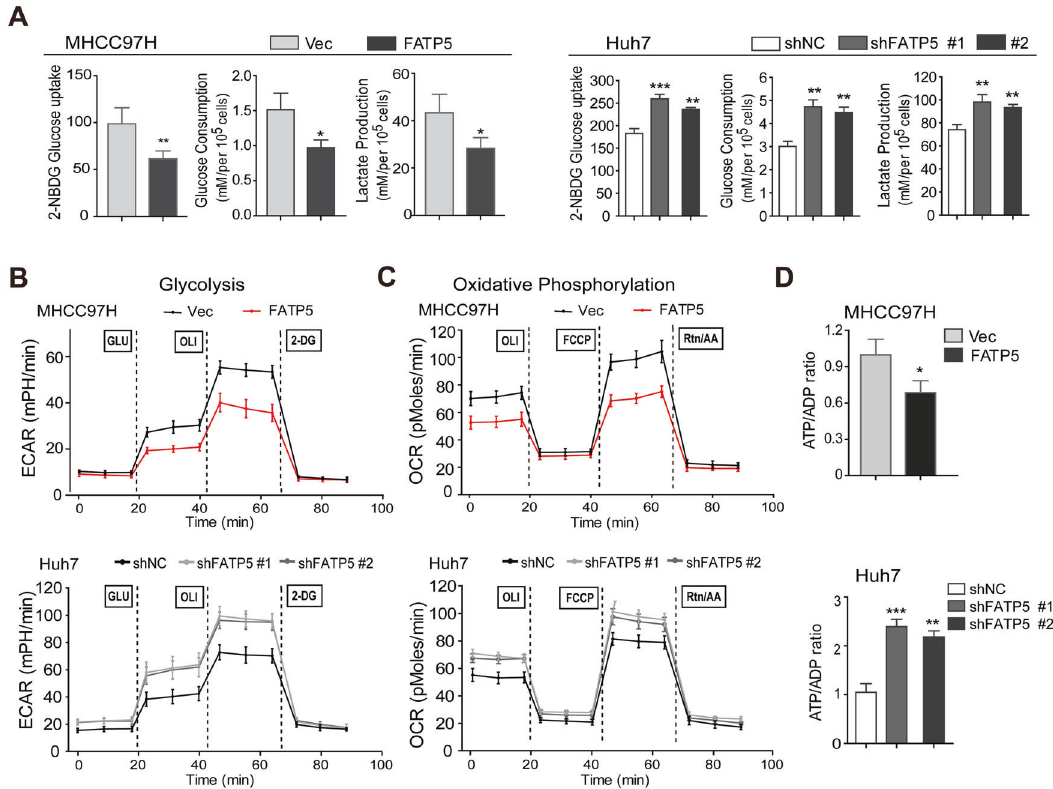
Fig. 4 FATP5 induces the activation of AMPK by reprogramming glycolysis and energy metabolism of HCC cells. A HCC cells were incubated with 2-NBDG for 30 min and then washed and re-suspended with DMEM medium. The cellular fl uorescence intensities were measured by fl ow cytometry. Glucose and lactate concentrations in normal culture medium and supernatants after cell incubation for 48 h were detected to calculate the glucose consumption and lactate production. B , C Both extracellular acidi fi cation rates (ECAR) and oxygen consumption rates (OCR) in different time points were measured using a Seahorse XF96 Extracellular Flux Analyzer either under basal conditions or after treatment with according inhibitors. Representative curves were shown and each data was presented as mean ± SD, with the average value of 6 independent wells. D The cellular ATP content in HCC cells was measured and the ATP/ADP ratio was expressed as the fold change relative to their corresponding Vec- or shNC-expressing cells (presented as equal to 1). All results in ( A ) and ( D ) were normalized to cell numbers and protein contents, respectively, * P < 0.05, ** P < 0.01 and *** P < 0.001 vs. negative controls. Abbreviations: OLI, oligomycin; FCCP, carbonyl cyanide p-tri fl uoromethoxy-phenylhydrazone; Rtn/AA, rotenone/antimycin; 2-DG, Based on loss- and gain-of-function experiments in vitro, FATP5 was proven to be a regulator of cellular metabolic pathways as well as a potent inhibitor of the EMT process. Further investigation of the mechanism indicated that FATP5 suppresses HCC invasion and metastasis by modulating the AMPK/mTOR/S6K pathway by reprogramming cellular energy metabolism (Fig. 6). Additionally, experimental animal models in vivo con fi rmed that the loss of FATP5 promotes HCC tumorigenesis and metastasis via the AMPK pathway, while activating AMPK by metformin reversed these effects and dramatically suppressed tumor progression. Collec- tively, our fi ndings demonstrate an anti-metastatic role of FATP5 in HCC and provide a promising prognostic predictor for HCC recurrence and survival. Cancer metastasis is a complex process including cell detachment from the primary tumor, circulation of migrated cells through blood vessels, and formation of secondary tumor foci after reaching distant organs [26]. During this period, cancer cells lose their cell-cell contacts and escape from the primary tumor site by acquiring mesenchymal features through the EMT process, which promotes the migration and invasion of cancer cells [27]. EMT is characterized by the loss of epithelial markers, such as E-cadherin, and enhanced expression of mesenchymal markers, including N-cadherin and vimentin. Therefore, we